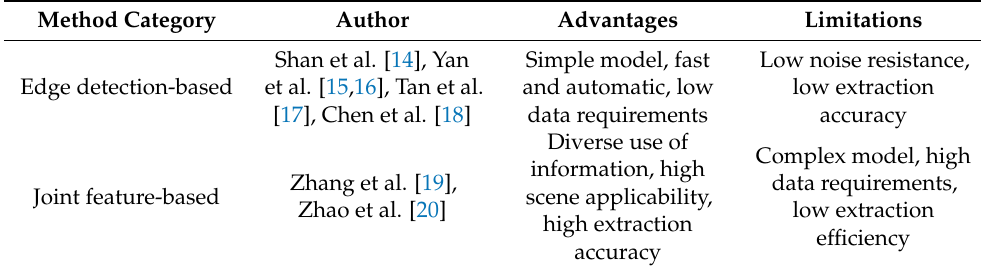
Table 1. Summary of methods discussed in the